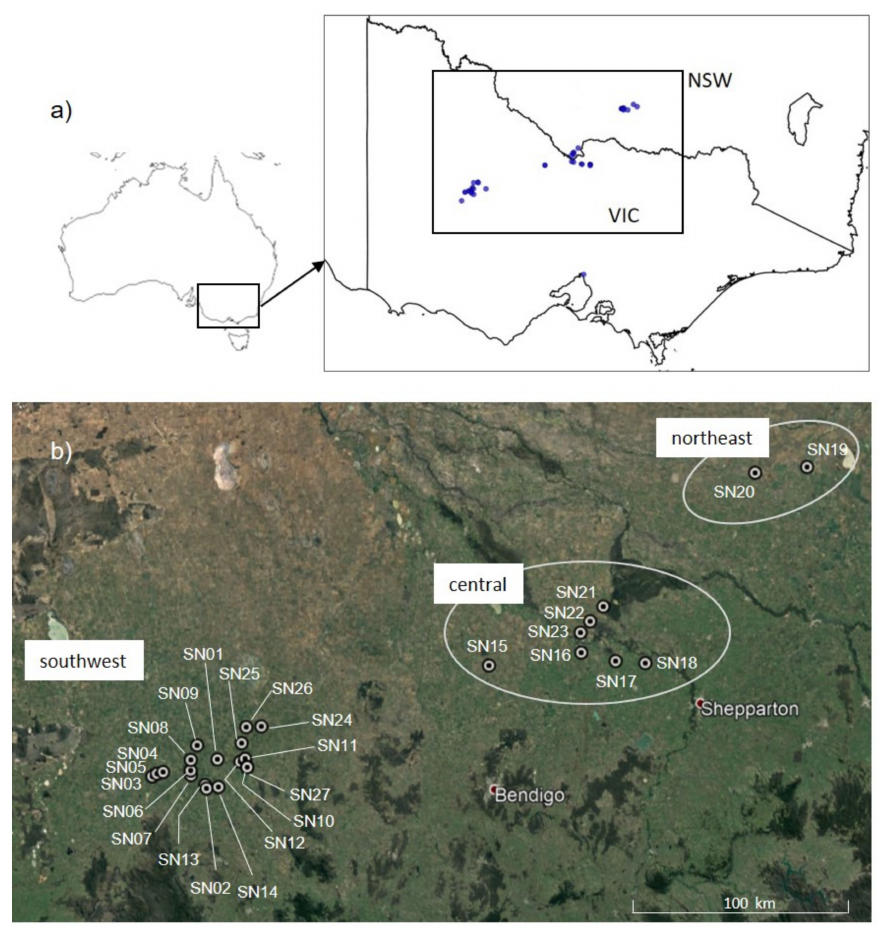
Figure 1. Distribution of Sclerolaena napiformis and location of sampled sites. ( a ) Geographic distribution based on herbarium records, indicated by blue dots, downloaded from Australasia’s Virtual Herbarium (AVH 2019). ( b ) Location of the three disjunct regions with sampled sites labelled.